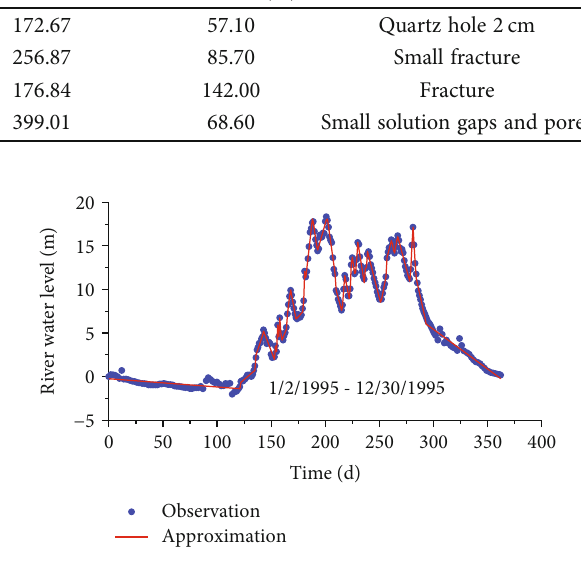
Figure 7: Linearization of the river water level in the year